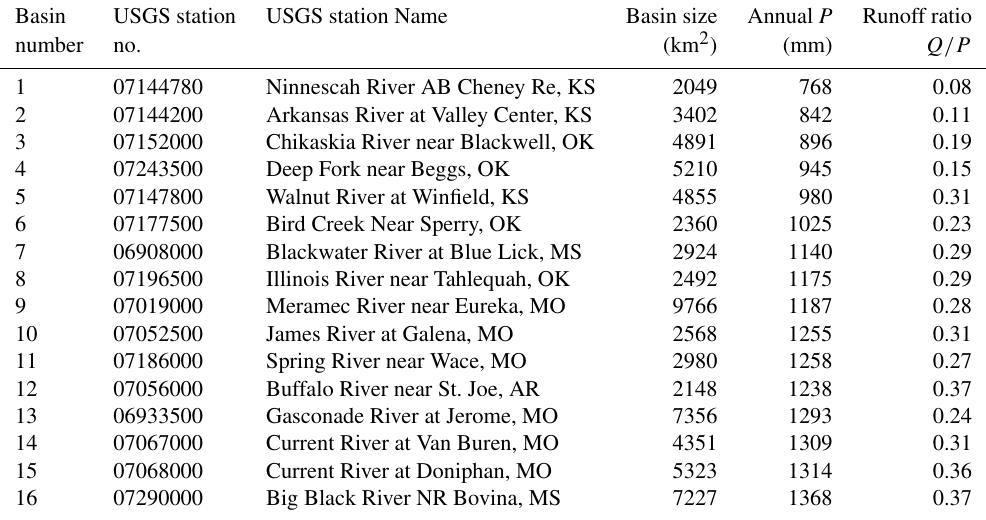
Table 2. Attributes of medium-scale basins in Fig. 1. Basin USGS station